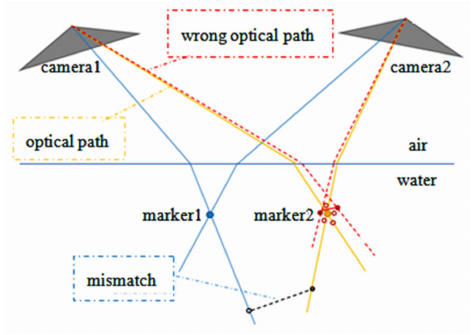
Figure 2. Marker matching diagram considering the error.